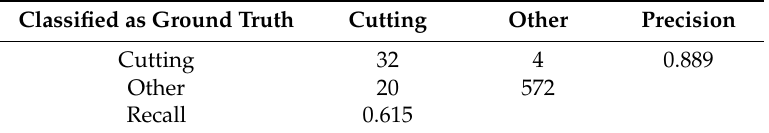
Table 13. Values for the optimal F ( F = 0.77, recall = 0.731, precision = 0.82). All